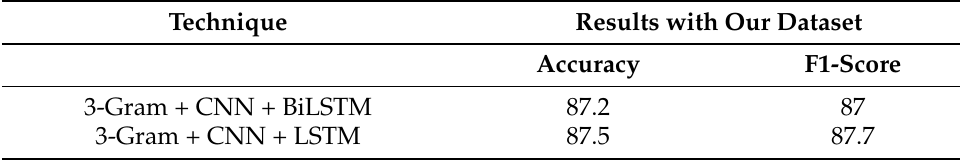
Table 13. Comparison of the methods applied on our